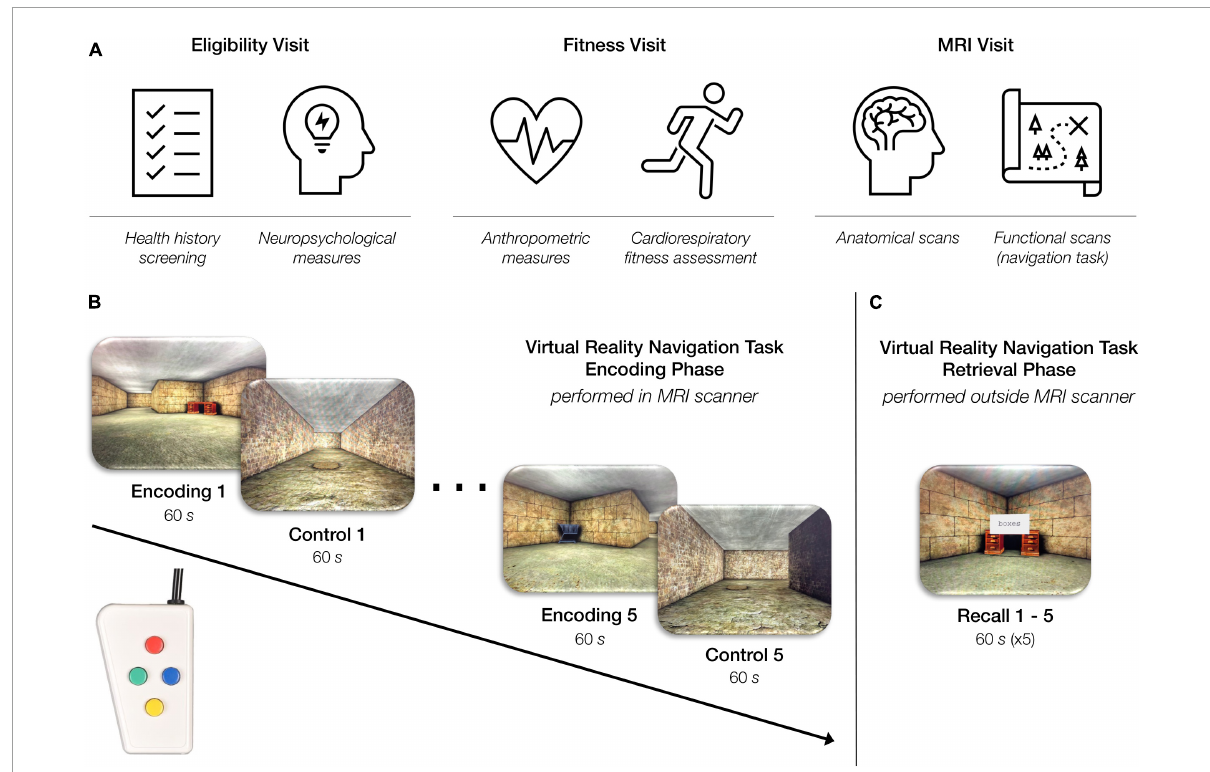
FIGURE1 Overview of study procedures. (A) Participants came in for three study visits: an eligibility visit, a fitness visit, and an MRI visit. (B) Virtual reality navigation task: encoding phase (inside the MRI scanner) . During the “encoding” condition of the task, participants were instructed to navigate through a series of rooms and interconnected hallways with the objective of learning the location of six objects placed within the environment. During the “control” condition of the task, participants were instructed to move through a hallway as quickly as possible while also traveling over a series of floor markers. The task alternated between the “encoding” and “control” condition every 60 s for a total of 10 min. Participants completed this phase of the task using a four-button, diamond-configuration response device to move in the virtual space. (C) Virtual reality navigation task: retrieval phase (outside the scanner) . Participants began at one object in the virtual environment and were instructed to navigate to another object using the shortest possible route. Upon correctly locating the specified object, the participant was instructed to find another object. This continued throughout the duration of the 60-s recall block. Each participant completed five 60-s recall blocks